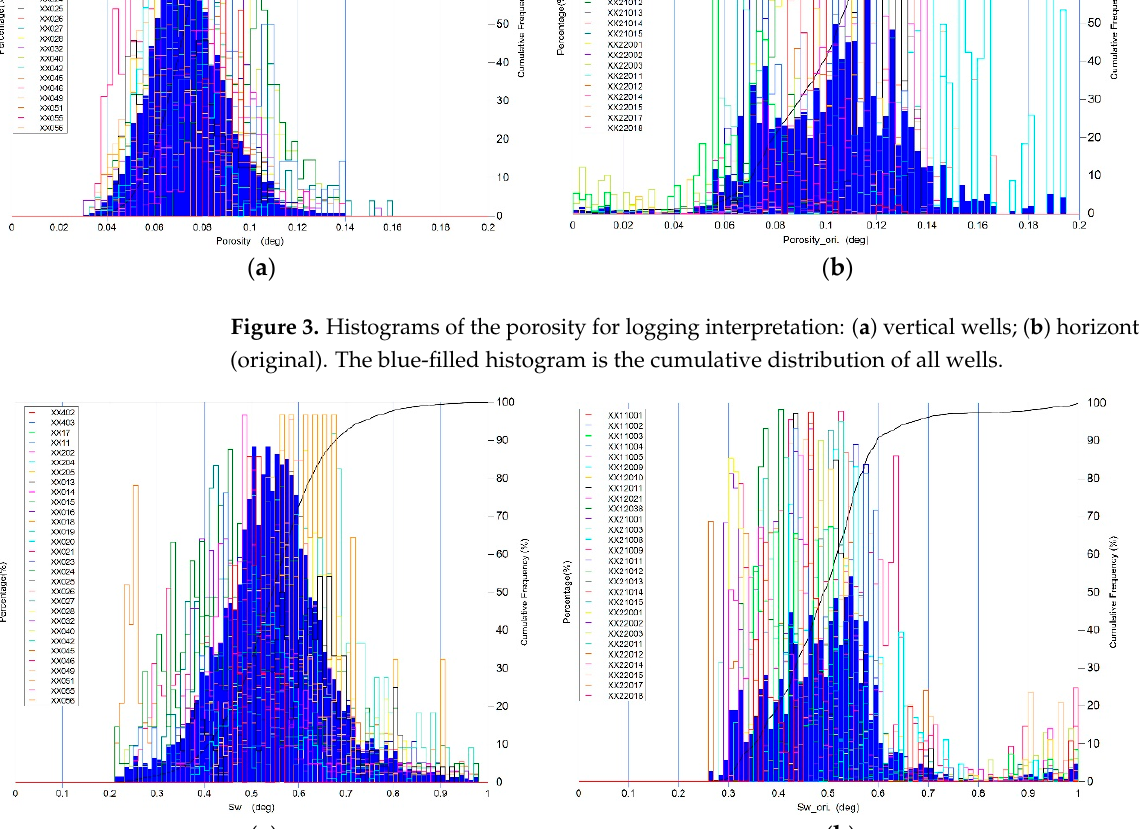
Figure 4. Histograms of water saturation for logging interpretation: ( a ) vertical wells; ( b ) horizontal wells (original). The blue-filled histogram is the cumulative distribution of all wells.